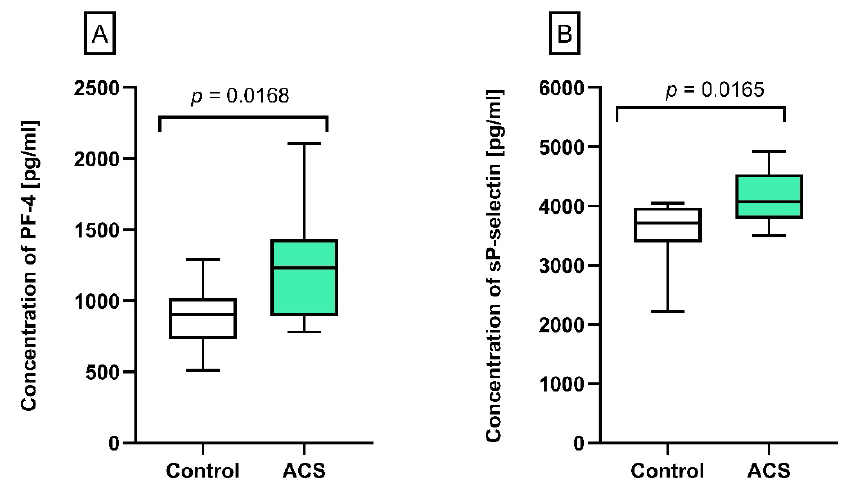
Figure 2. Analysis of blood platelet activation markers in plasma samples. ( A ) The concentration of PF-4 [pg/mL] and ( B ) sP-selectin [pg/mL] were measured by the ELISA test in plasma from patients with ACS ( n = 12) and healthy subjects ( n = 12). The results were presented as the median with an interquartile range (Q1–Q3; whiskers—the minimum and maximum value, respectively). Statistical analysis was performed using the Mann–Whitney U test.